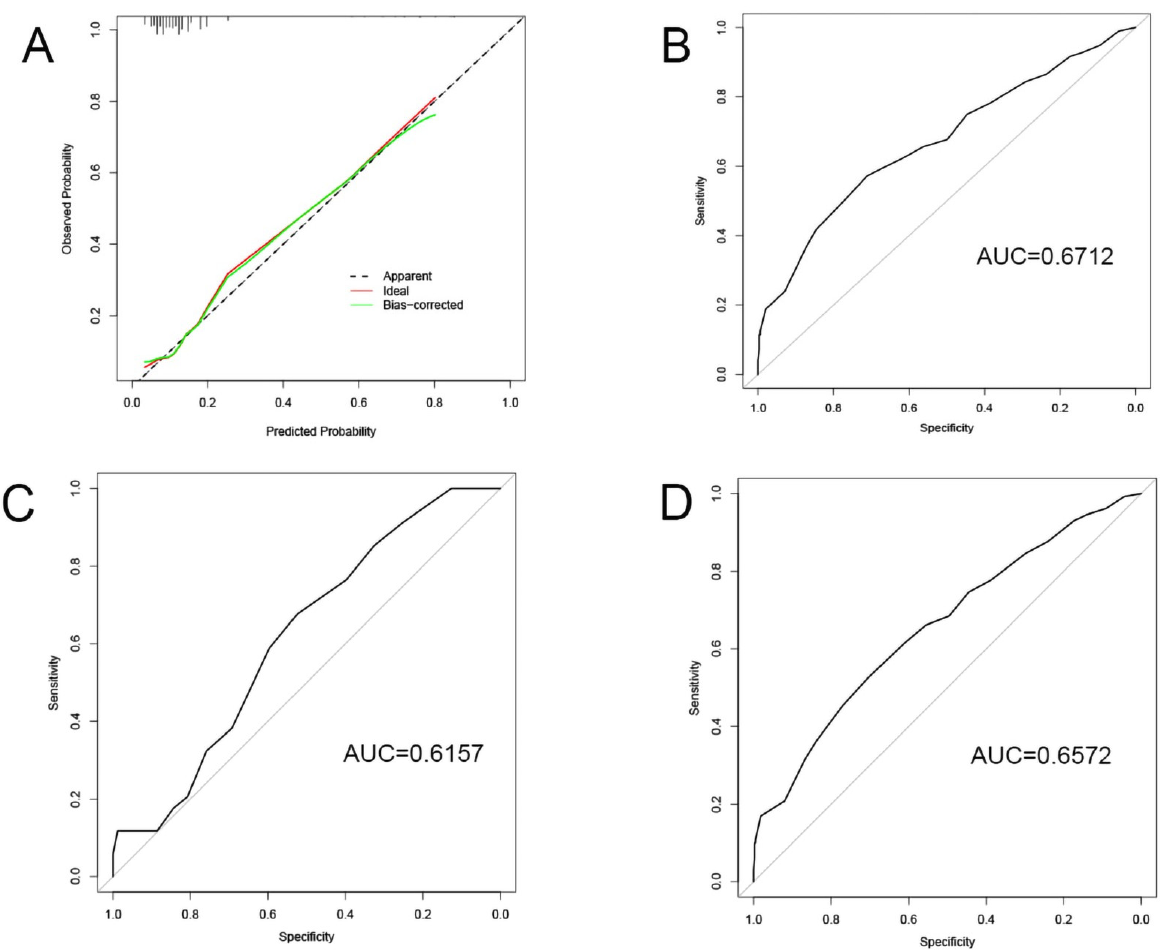
Figure 5. Validation of the model: ( A ) Calibration curve; ( B – D ) ROC curves of training set, testing set, and whole set.